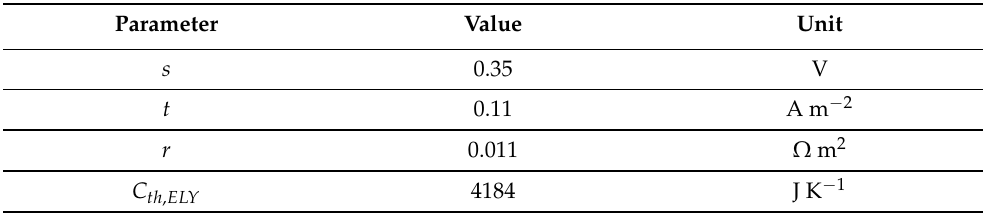
Table 3. Alkaline electrolyser. Parameters of thedynamic model. Parameter